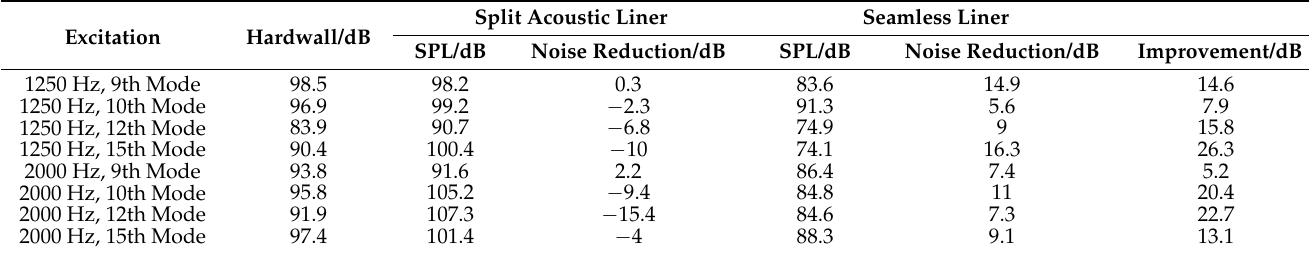
Table 5. Analysis of noise reduction under different acoustic modes